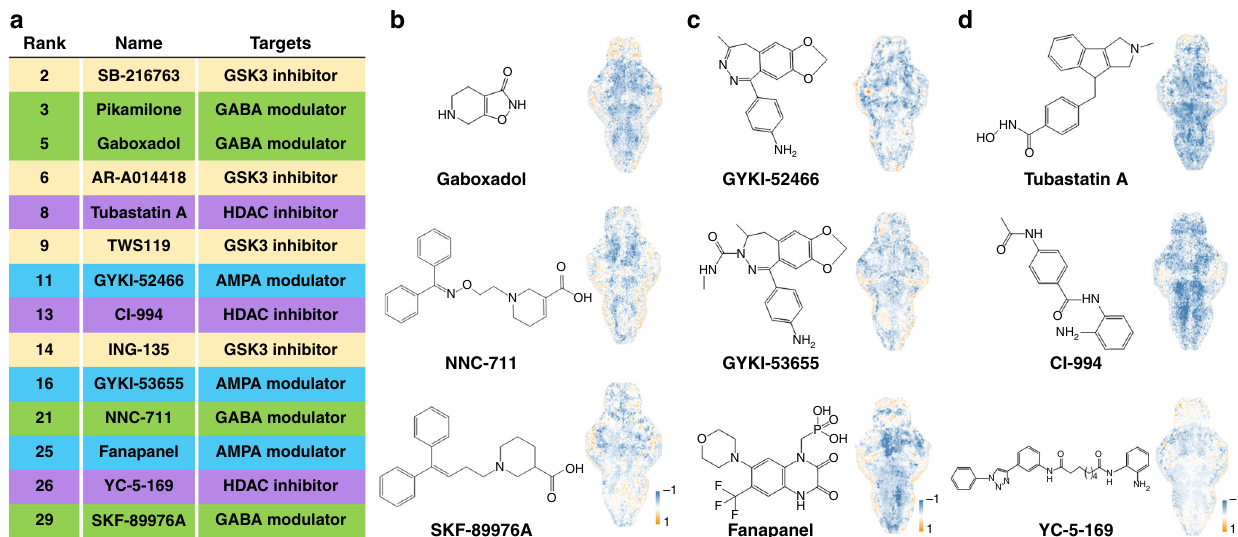
Fig. 5 Prediction of the nonclinical compounds using the HT-BAMing technology. a List of top-rated compounds predicted to be potent N03:Antiepileptic drug candidates. Compounds sharing the same molecular targets were shaded in the same color. b − d The chemical structures of several predicted potent antiepileptic compounds with distinct molecular targets, including b GABA modulators (gaboxadol, NNC-711 and SKF-89976), c AMPA modulators (GYKI- 52466, GYKI-53655 and fanapanel), and d HDAC inhibitors (tubastatin A, CI-994 and